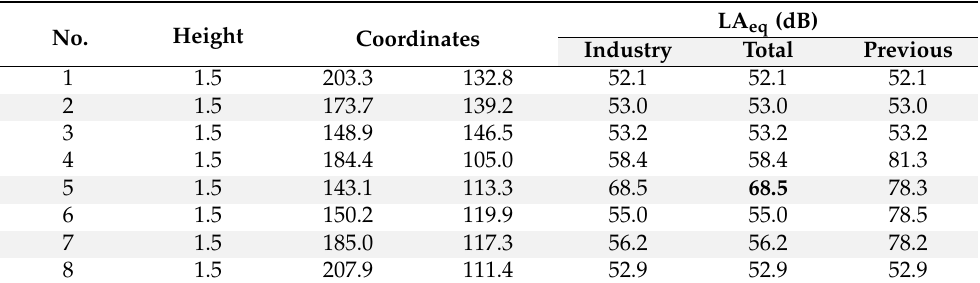
Table 6. Table of calculated values of measured points for demolition work after considering acoustically significant elements, including construction site fencing and a solid gate for the entrance to the construction site in the investigated area.